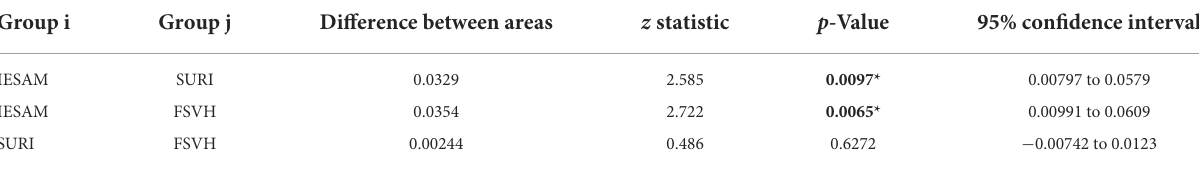
TABLE 4 Multiple comparison of the area under the ROC curve of the three imaging scoring methods. Group i